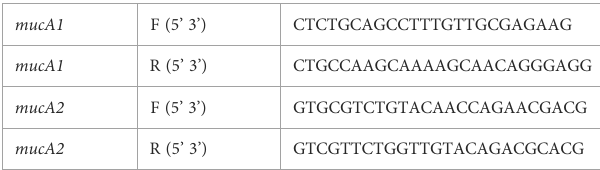
TABLE 1 Ampli fi cation and sequencing primers for